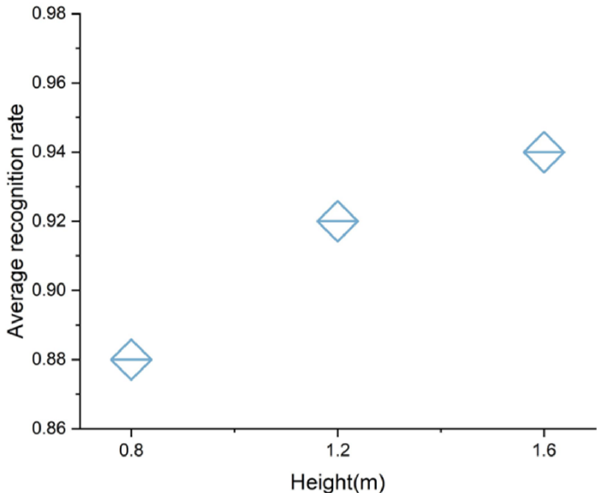
Figure 12. Influence of height on recognition rate.